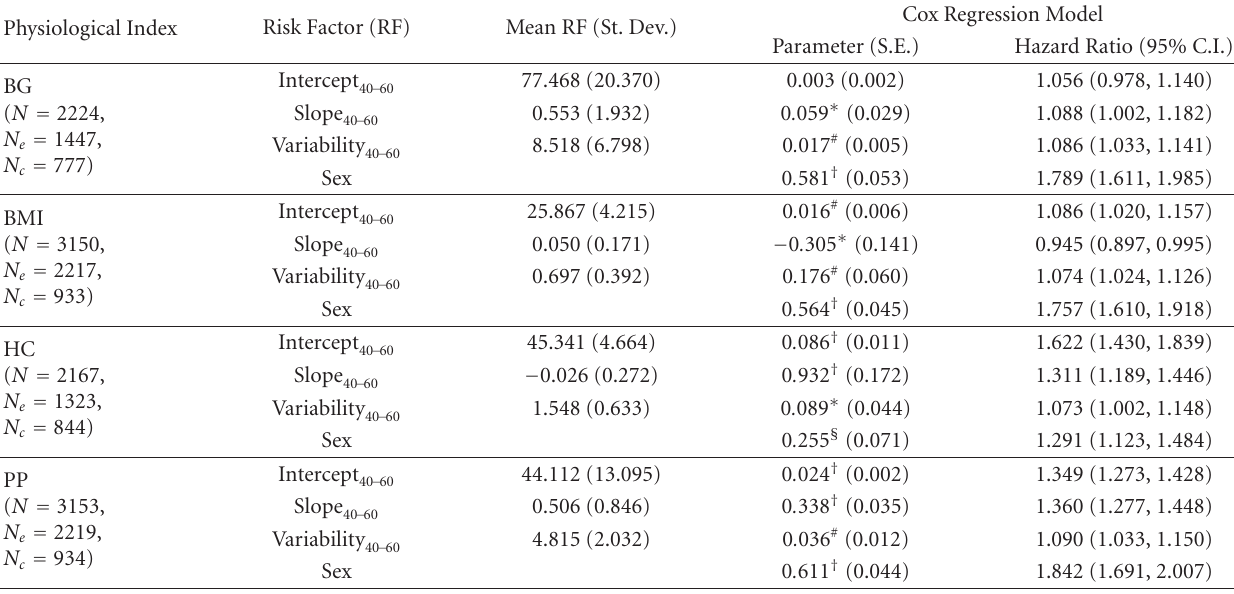
Table 1: E ff ect of “dynamic” risk factors calculated from individual trajectories of physiological indices at ages 40–60 on mortality risk at ages 60+ in the Framingham Heart Study (original cohort) estimated by the Cox proportional hazards model.